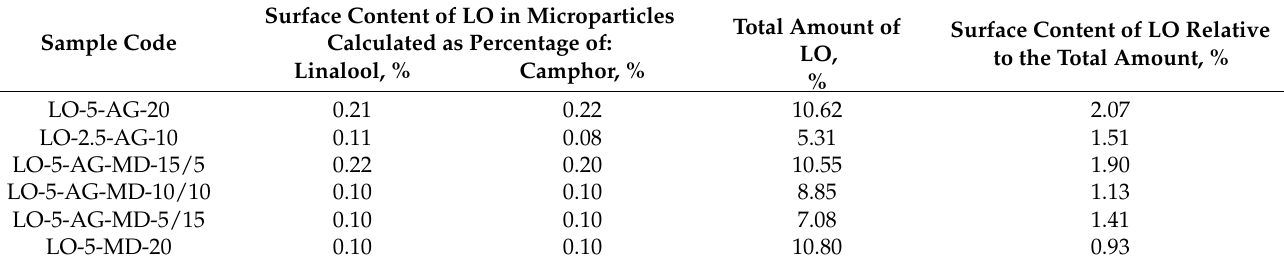
Table 3. Surface content and total amount of lavender oil in